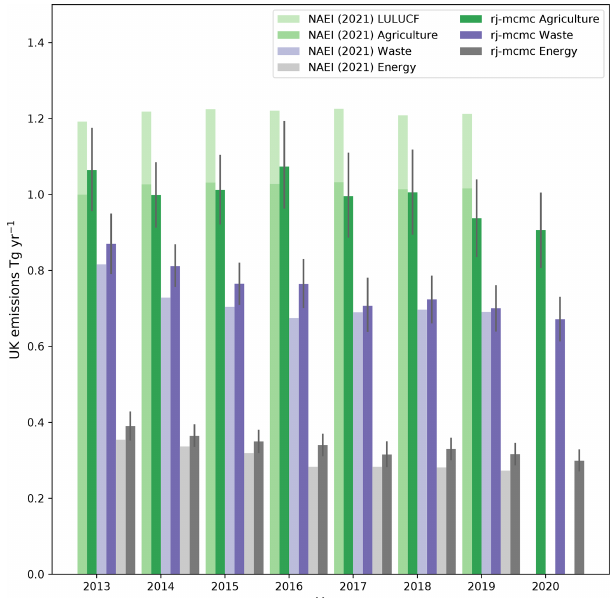
Figure 5. Annual UK emission estimates for agriculture and LU- LUCF (green), waste (purple) and energy (grey) sectors. The lighter shade in each colour represents the NAEI value, while the darker shade shows the average posterior distribution from the rj-mcmc inversion. Uncertainty bars represent the 95% confidence interval. Sector totals are calculated by scaling the individual prior sector distributions by the total posterior scale factor of each grid box. The rj-mcmc sector breakdown does not include an explicit representa- tion of